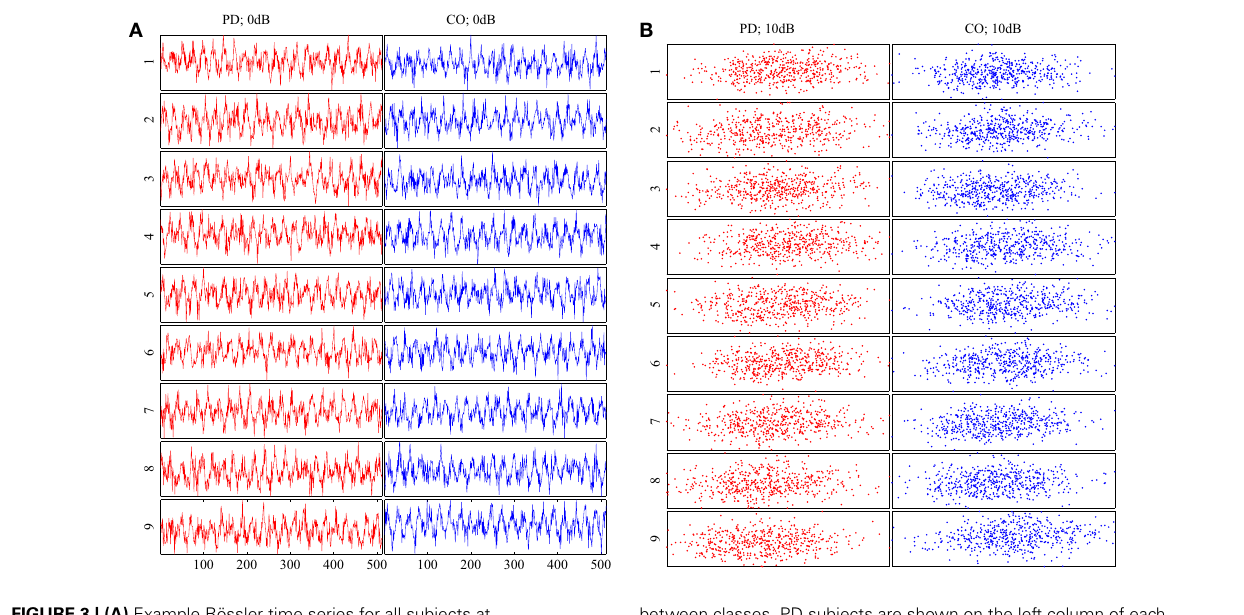
between classes. PD subjects are shown on the left column of each diagram in red. CO subjects are shown on the right column of each diagram in